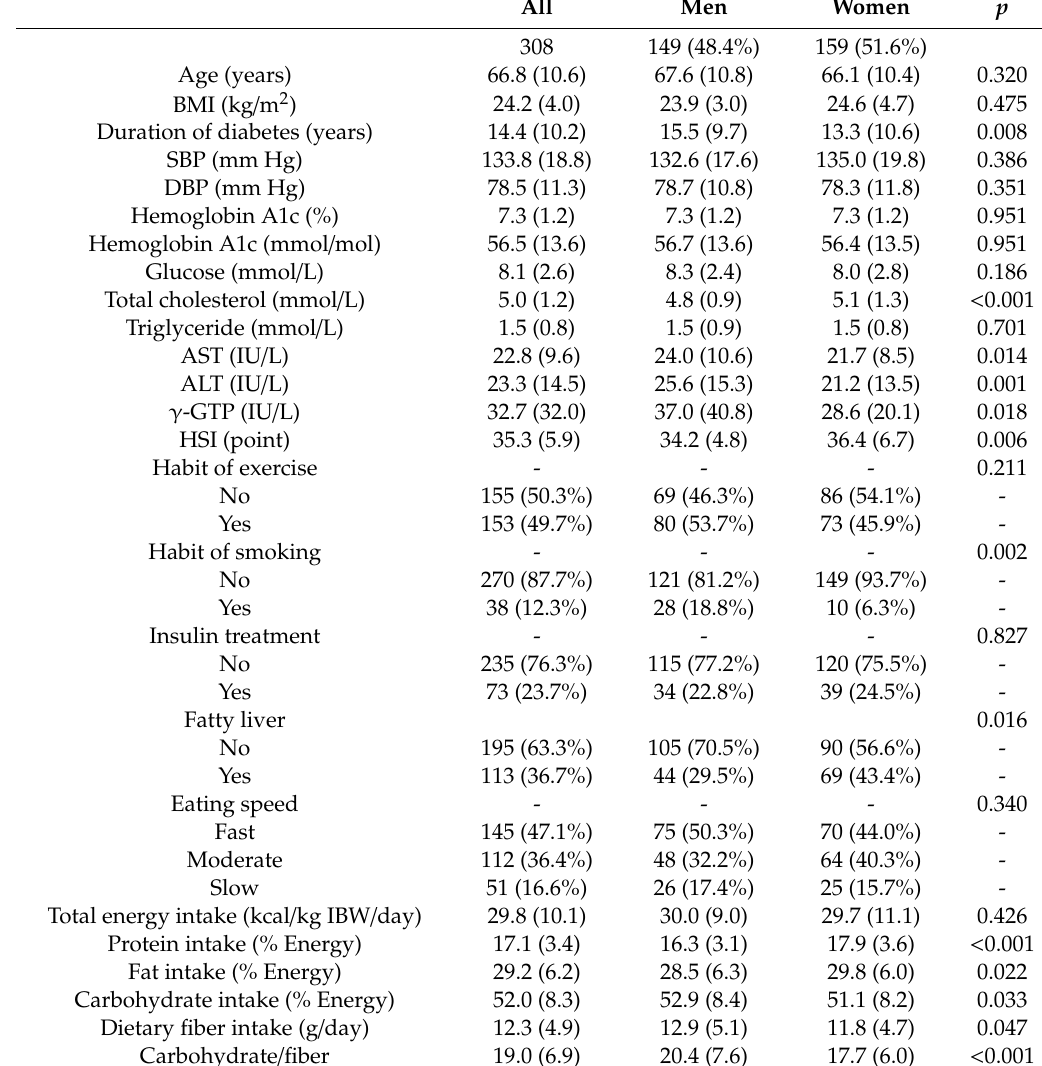
Table 1. Clinical characteristic of study